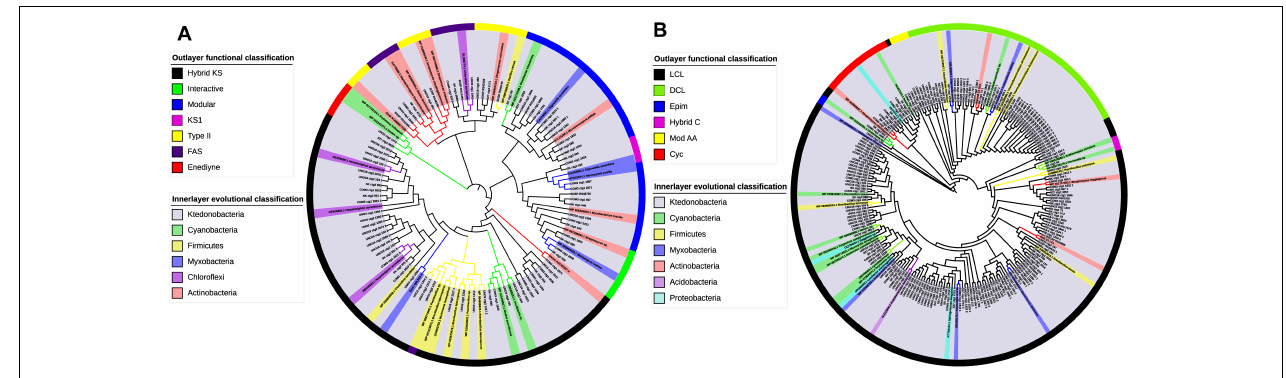
FIGURE 6 | Functional and evolutionary analysis of Ktedonobacteria PKS KS and NRPS C domains. (A) Domain-specific phylogenetic analysis of the Ktedonobacteria amino acid sequences extracted from KS domains. The reference sequences include three top hits from Protein-Protein Blast and the NaPDoS reference database. Maximum-likelihood phylogenetic tree of the Ktedonobacteria KS domains was built in MEGA v. 7.0. The evolutionary classification was shown in the inner layer color strip whereas the outer layer color strip represents the functional classification of the KS domains. (B) Domain-specific phylogenetic analysis of the Ktedonobacteria amino acid sequences extracted from C domains. The analysis was created as for (A) .